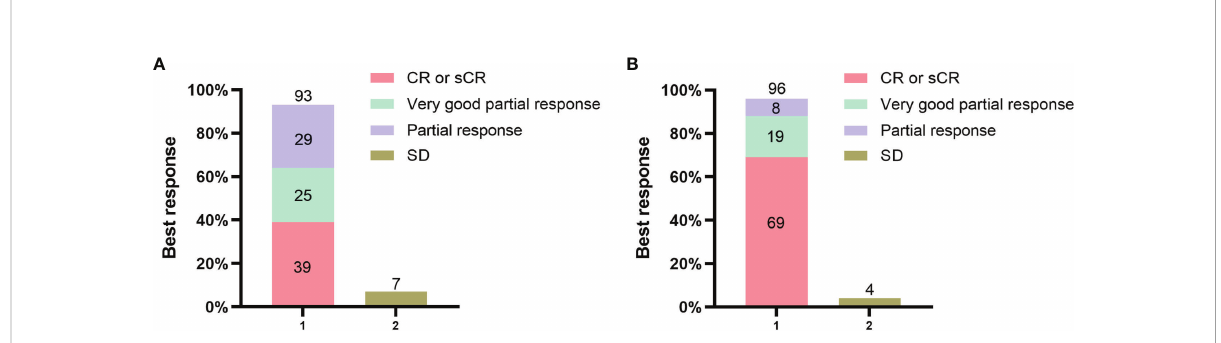
FIGURE 1 Response to the combination of anti-BCMA and anti-CD19 chimeric antigen receptor (CAR) T cells. Panel (A) shows the rates of overall response and no response in the PHT group. Panel (B) shows the rates of overall response and no response in the non-PHT group. All responses were con fi rmed and assessed on the basis of the International Myeloma Working Group Uniform (IMWG) Response Criteria for Multiple Myeloma.